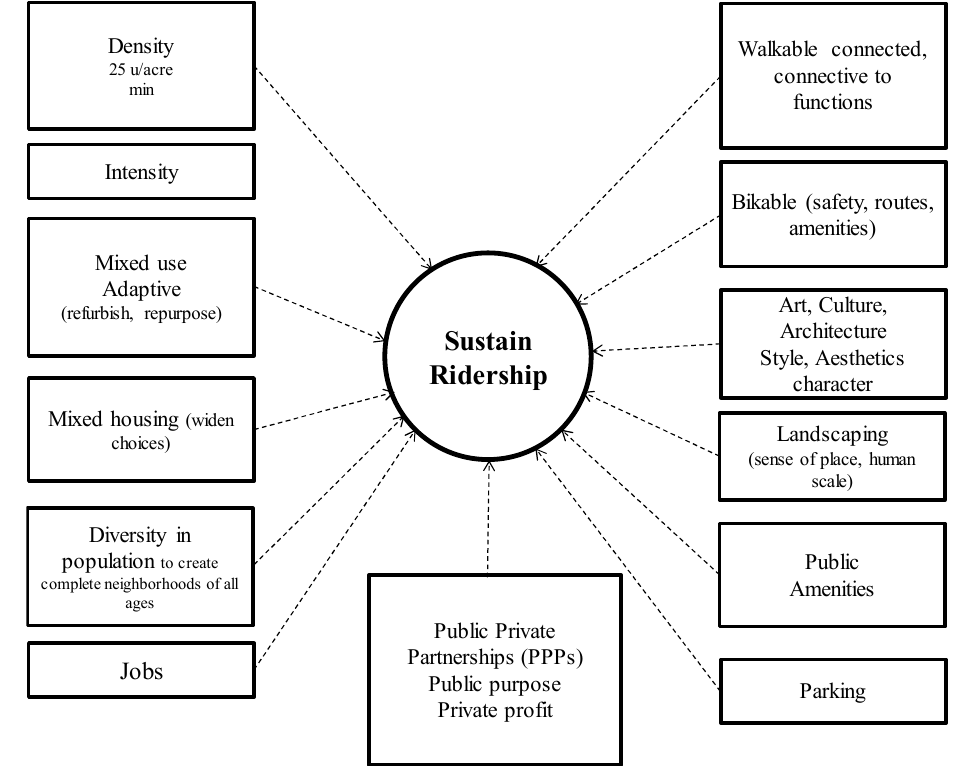
Figure 11. Railway transport is expensive to build, operate, and maintain; and therefore, sustaining